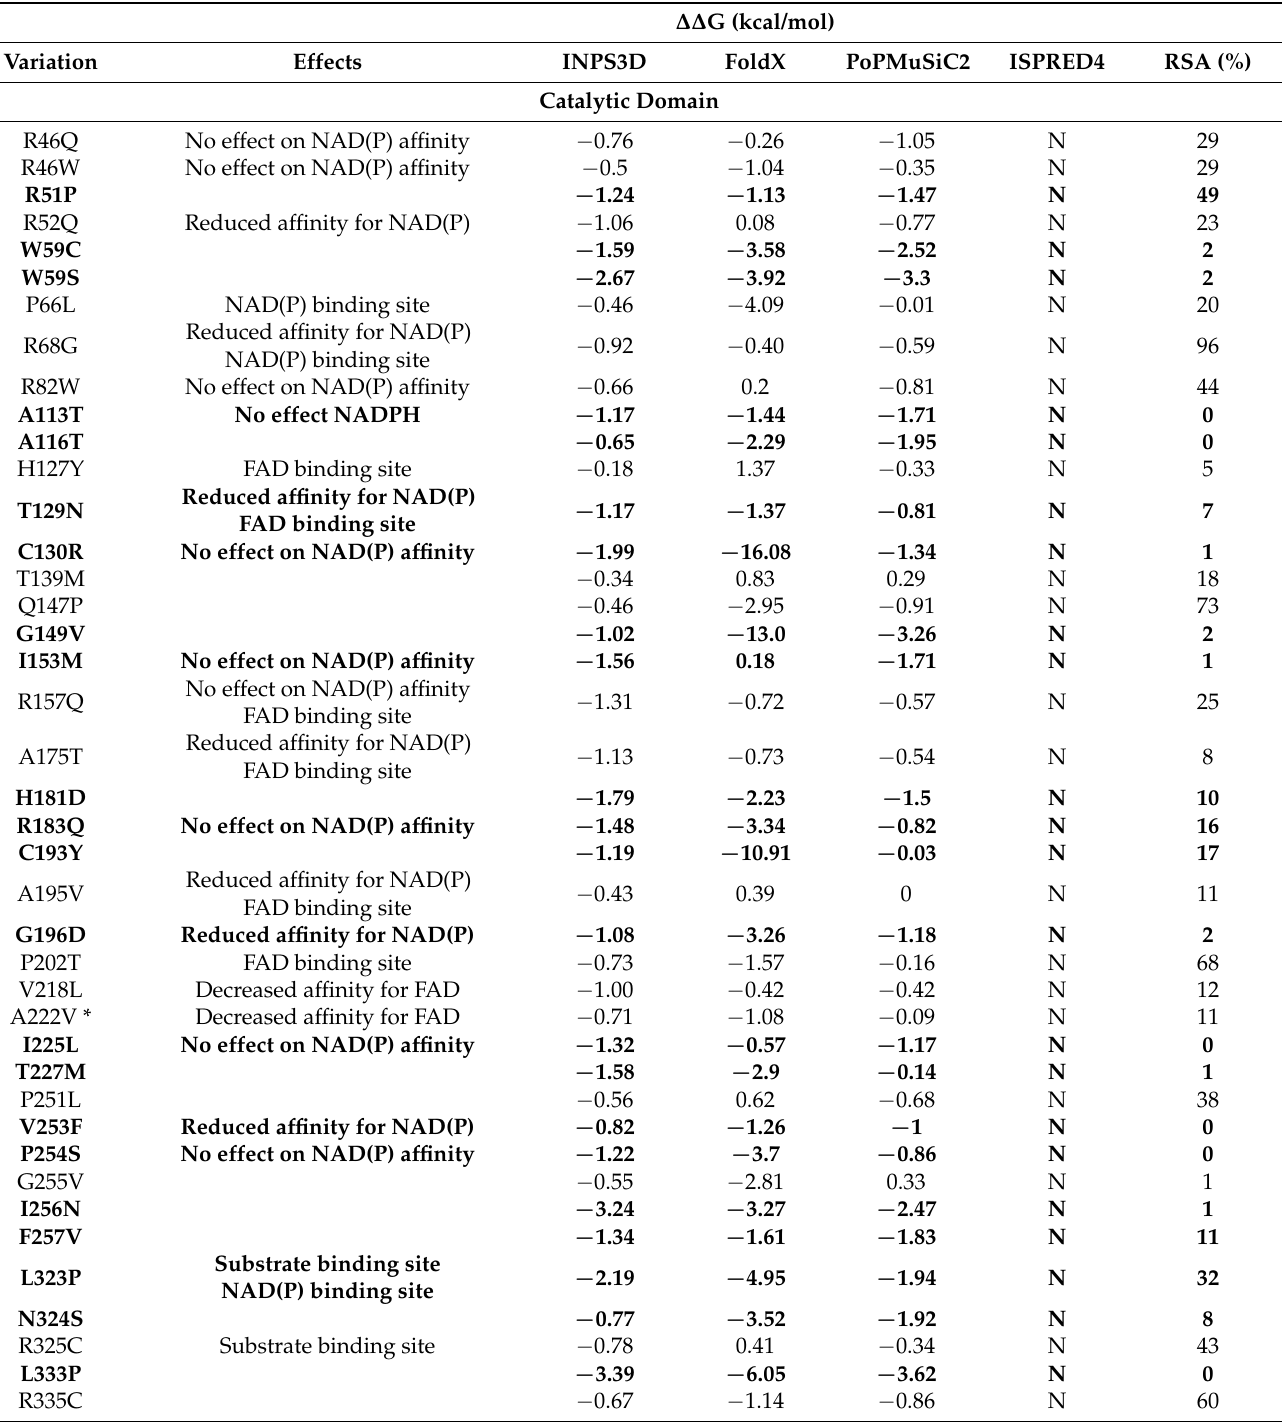
Table 1. MDHFR deficiency-related